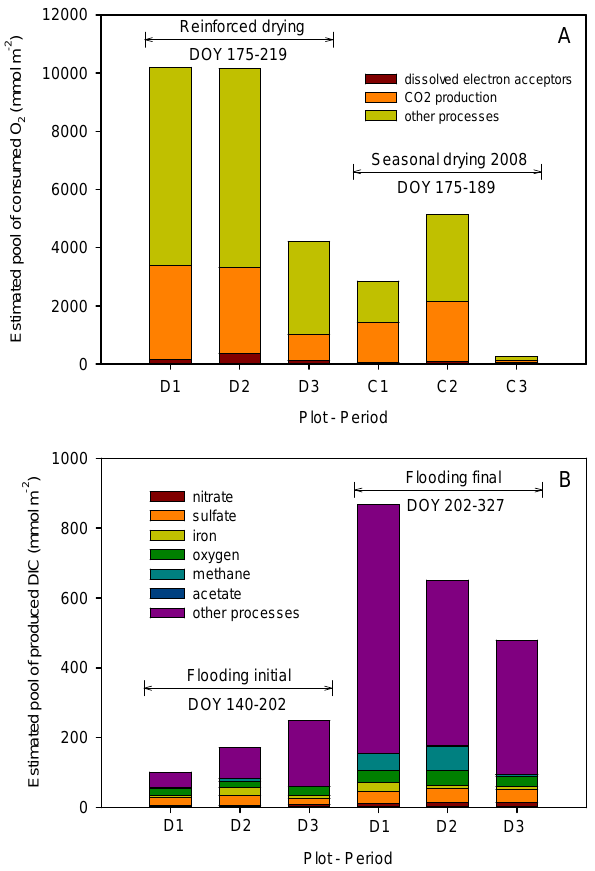
Fig. 11. (A) Cumulative pool of O 2 consumed during seasonal and reinforced drying in 2008. Oxygen consumption explained all CO 2 production in the gas phase and all the renewed electron accep- tors (shown in Fig. 10) during drying. (B) Cumulative pool of DIC produced over time during flooding and fractions explained by dis- solved electron acceptors, methanogenesis and acetate production. Other processes like the regeneration and consumption of electron acceptors in the solid phase likely constituted an important fraction of the unexplained O 2 consumption during drying and of CO 2 pro- duction during flooding, respectively (see